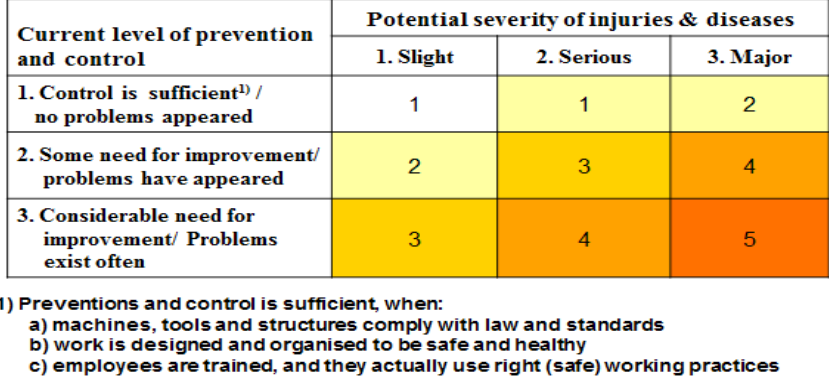
Table 1. The new risk assessment matrix